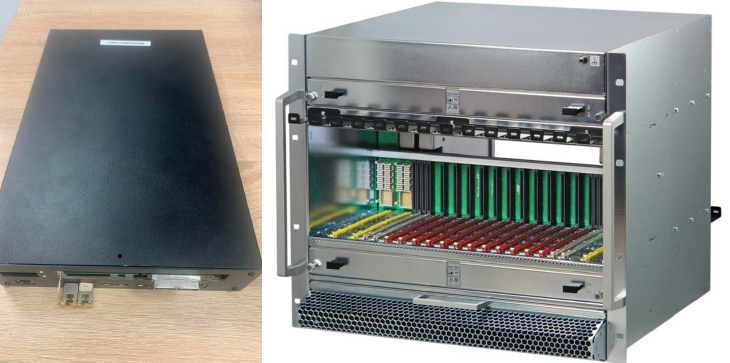
Figure 9. mTCA chassis for one AMC board ( left ) and standard mTCA rack for up to 12 AMC ( right